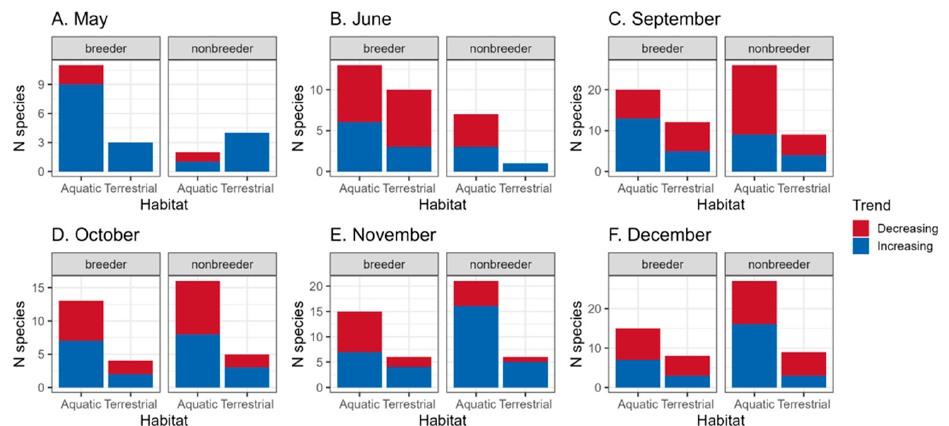
Figure 7. Number of species with increasing (blue) or decreasing (red) abundance of individuals,